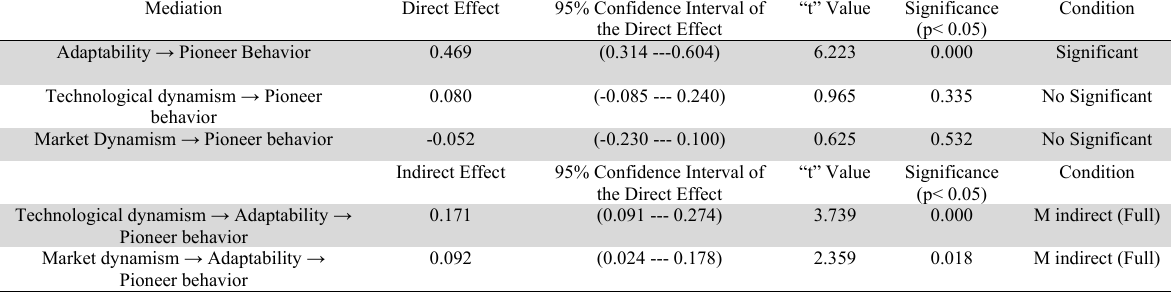
Analysis of the market and technological dynamism mediation model in pioneering behavior through adaptive capacity